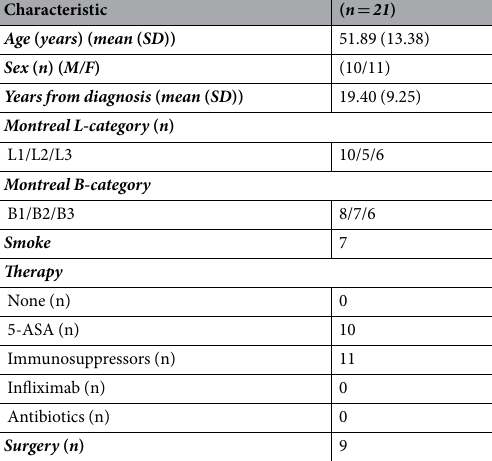
Table 1. Clinical characteristics of the Crohn’s disease study